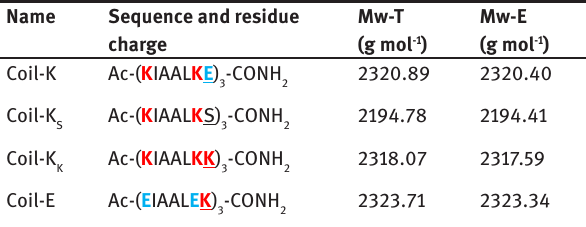
Table 1: Information of peptide primary structure. Red letters stand for positive charged amino acid residues, while blue letters stand for negative charged amino acid residues. Underline indicates the ‘f’ position. Sequence presents from N terminus to C terminus. All peptides were acetylated. Mw-T is molecular weight in theoretical, while Mw-E is molecular weight in